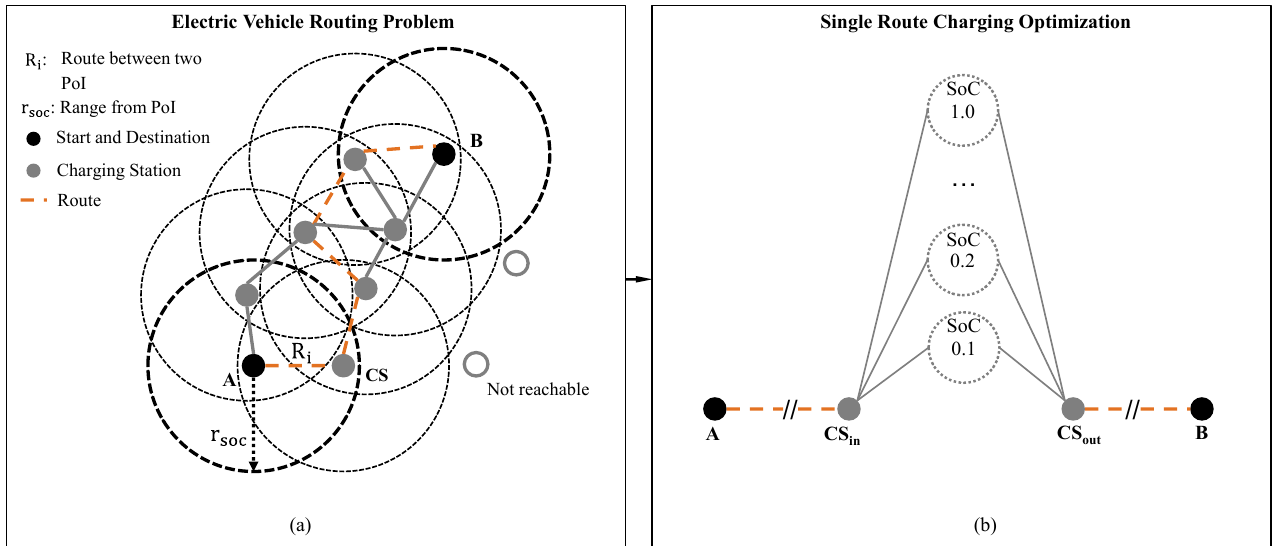
Figure 1. ( a ) Integration of a charging strategy in EVRP according to [17]. Starting from PoI A, searching for charging stations (CS) in range r soc from the PoI, calculating routes R i between PoIs (A, B, CS), and finding the optimal connection between A and B via routes R i . ( b ) Directed graph for charging strategy optimization according to [18]. Discretization of the SoC leads to imaginary nodes (e.g., SoC 1.0) between the incoming charging station node (CS in ) and outgoing node (CS out